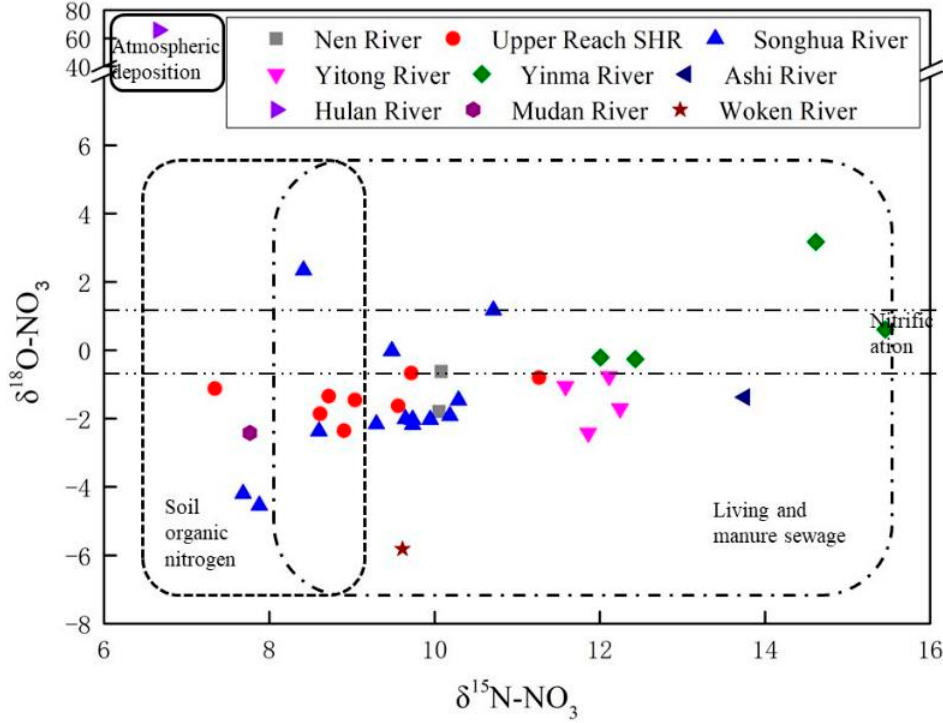
Figure 2. The relationship between δ 15 N and δ 18 O values of nitrate in the SHR during low flow season. flow